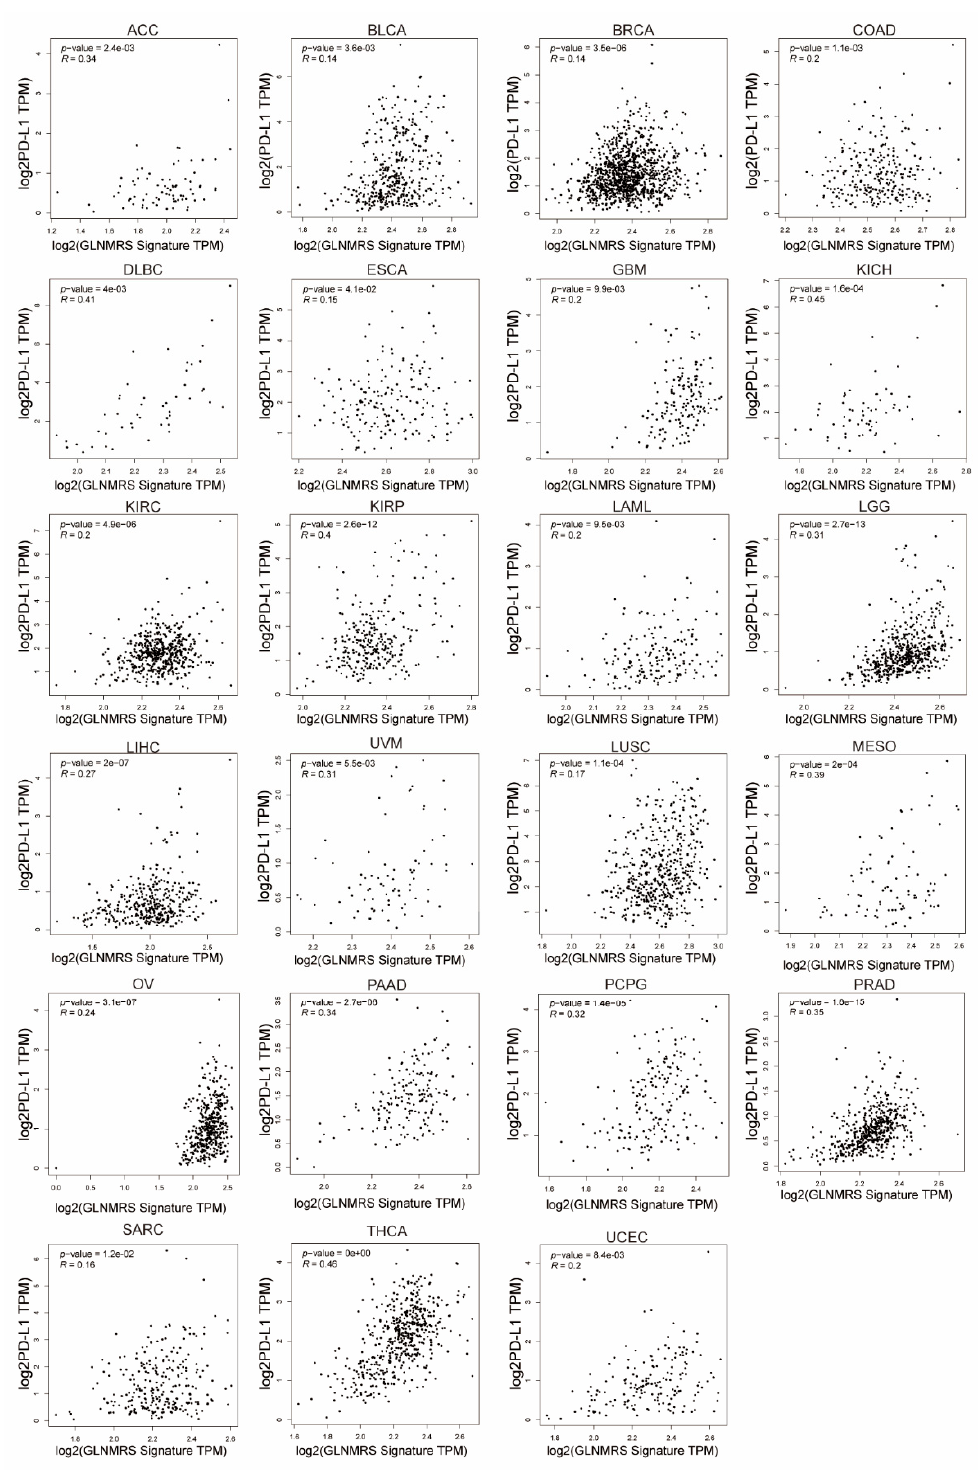
Figure 7. Glutamine metabolism (GLNM) regulator expression is significantly positive correlated with PD-L1 expression in ACC, BLCA, BRCA, COAD, DLBC, ESCA, GBM, KICH, KIRC, KIRP, LAML, LGG, LIHC, LUSC, MESO, OV, PAAD, PCPG, PRAD, SARC, THCA, UCEC, and UVM (all p < 0.05).